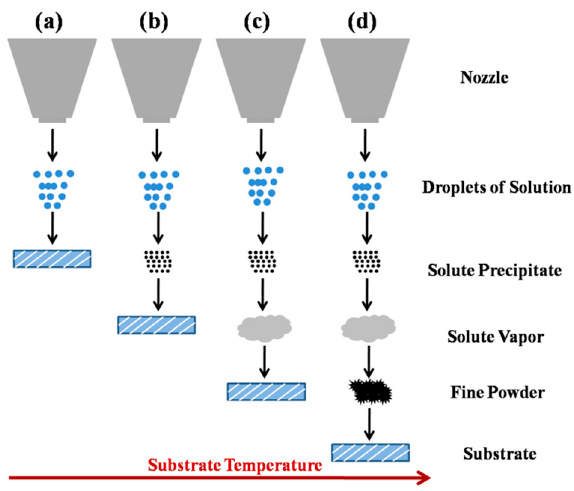
Figure 6. Dynamics of USP with different substrate temperature.